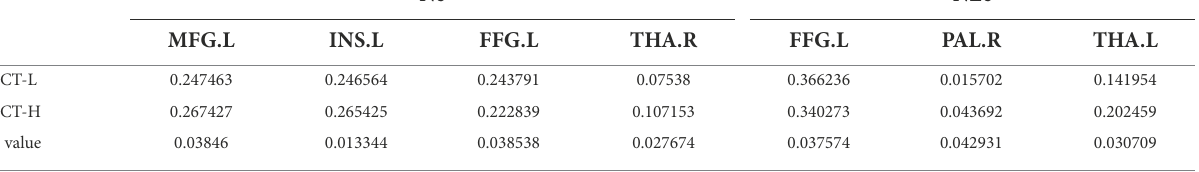
TABLE 6 Nodal efficiency and nodal local efficiency.